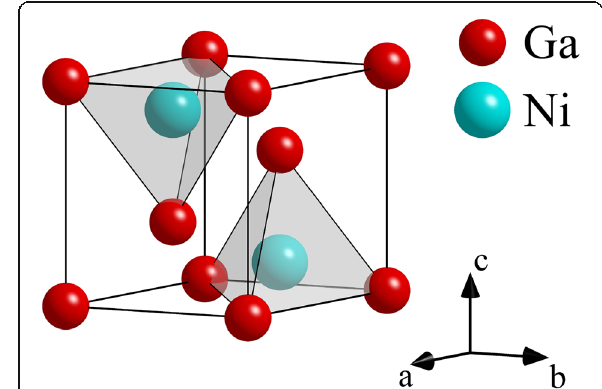
Fig. 1 The Ga 3 Ni 2 trigonal unit cell (Wencka et al. 2016; Hellner and Laves